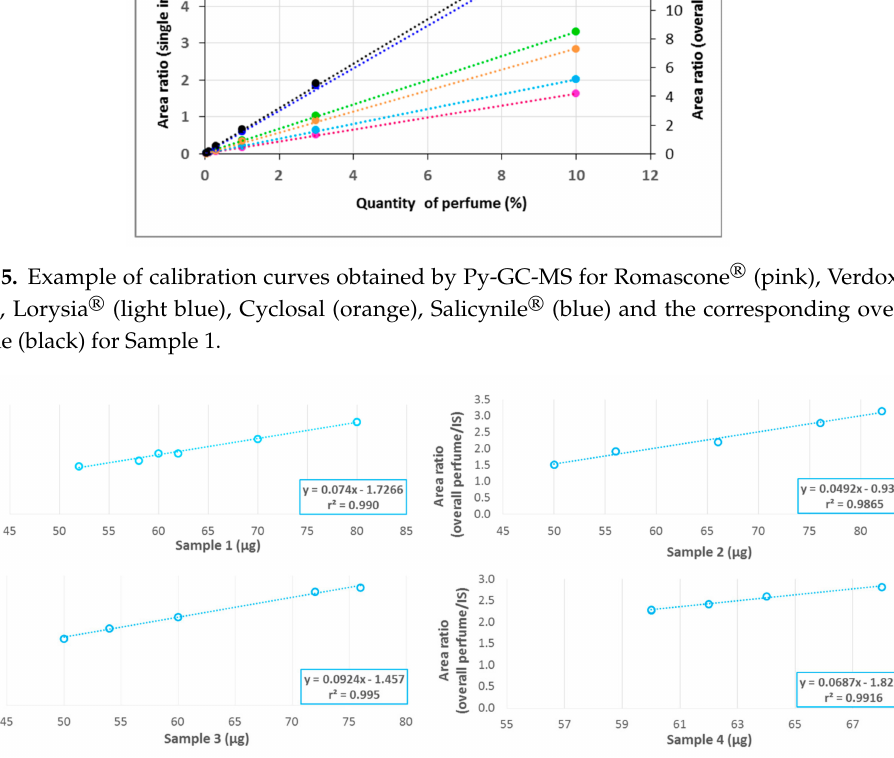
Figure 6. Py-GC-MS repeatability studies for Sample 1 (upper left), Sample 2 (upper right), Sample 3 (lower left) and Sample 4 (lower right). At least five independent replicates were